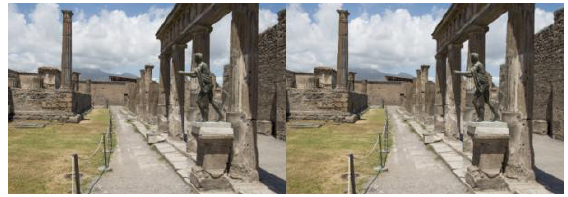
Figure 2. Stereoscopic shots Apollo’s Temple right side